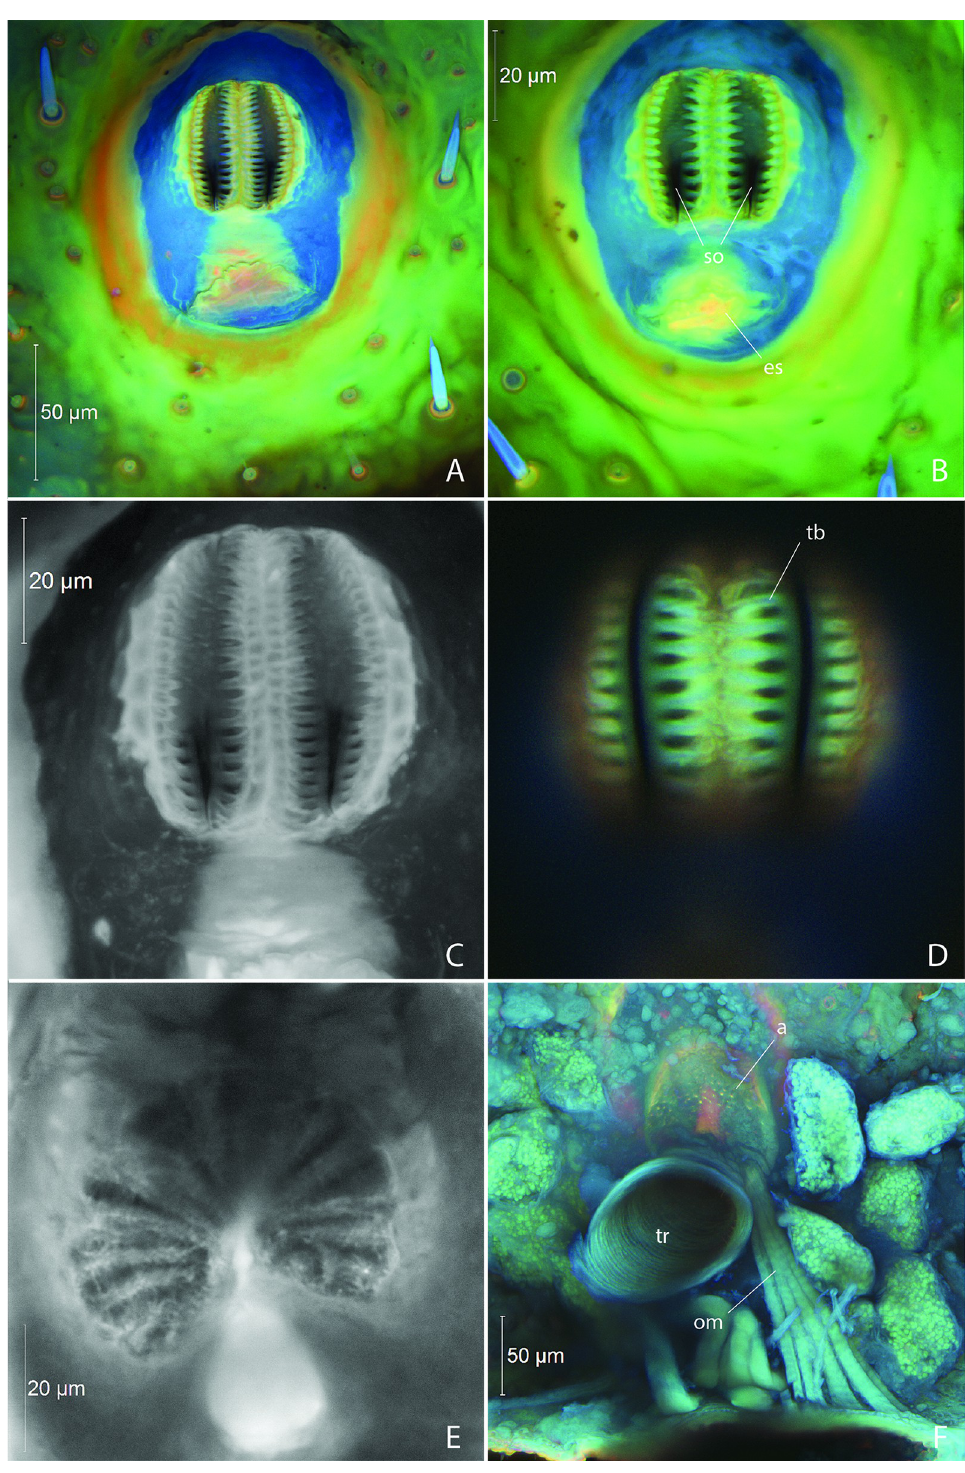
Fig 4. Larval abdominal spiracles in Photinus pyralis . A, segment III spiracle, external view; B, segment VI spiracle, external view; C, segment VI spiracle, enlargement of external view; D, segment VI spiracle, enlargement showing parallel trabeculae along lateral margins of spiracular openings; E, segment VI spiracle, optical section between spiracular opening and atrium, showing dendriform filter apparatus; F, segment VI spiracle, internal view showing atrium and occlusor muscle. Abbreviations: a, atrium; es, ecdysial scar; om, occlusor muscle; so, spiracular opening; tb, trabeculae; tr, trachea. https://doi.org/10.1371/journal.pone.0268112.g004 PLOS ONE | https://doi.org/10.1371/journal.pone.0268112 June 1,